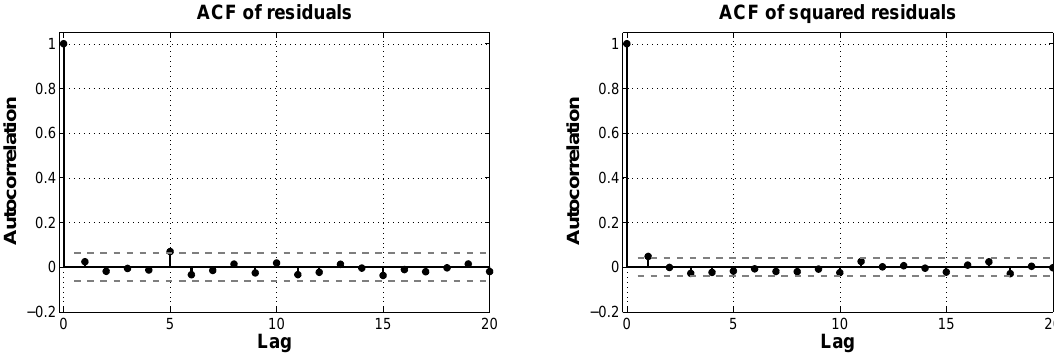
Fig. 5. Autocorrelation function for ARMA-GARCH residuals for precipitation (1979–1993) of Garmisch-Partenkirchen (top), and its corresponding squared residuals (bottom).